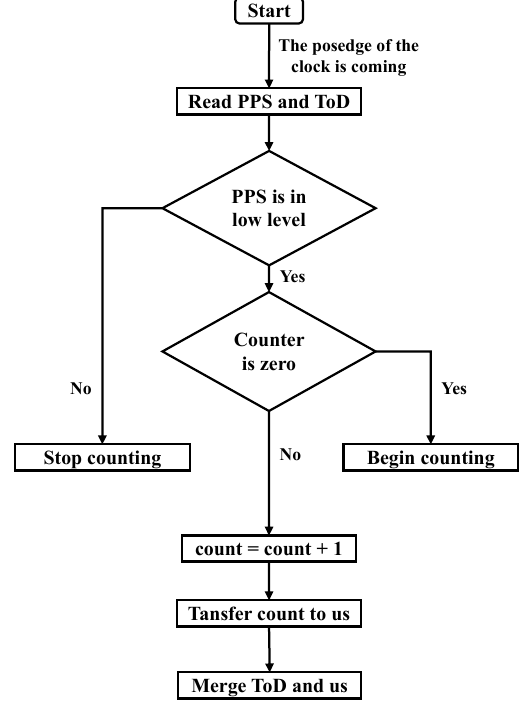
Figure 3. The flow chart of the control of clock synchronization module.